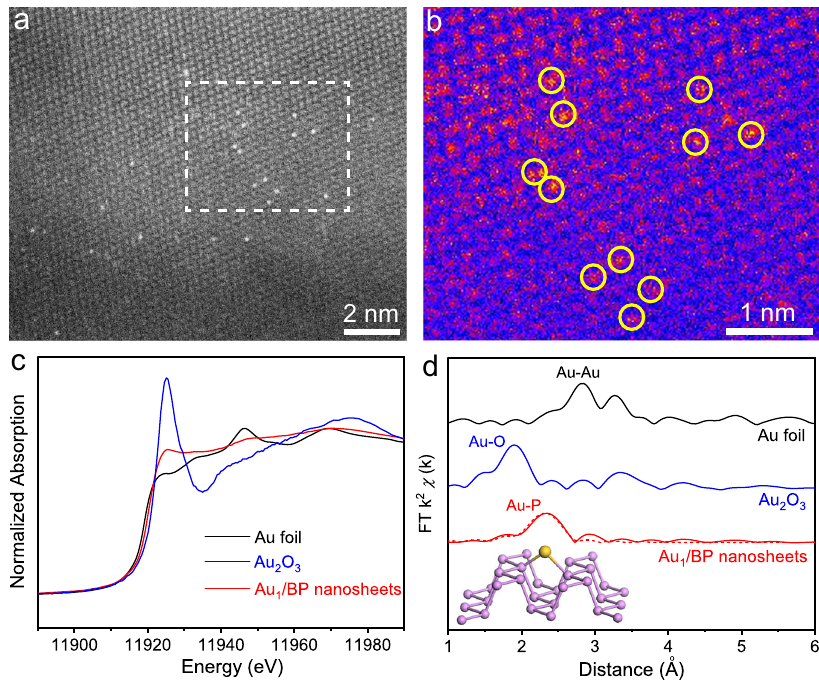
Fig. 1 Structural characterizations of Au 1 /BP nanosheets. a HAADF-STEM image of Au 1 /BP nanosheets. b Magni fi ed HAADF-STEM image with color- coded intensity. This image shows the region marked by dash box in a . c XANES spectrum and d EXAFS spectrum of Au 1 /BP nanosheets. Au foil and Au 2 O 3 were used as the references. The inset image in d is a structural model of Au 1 /BP nanosheets. Violet and yellow spheres represent for P and Au atoms,